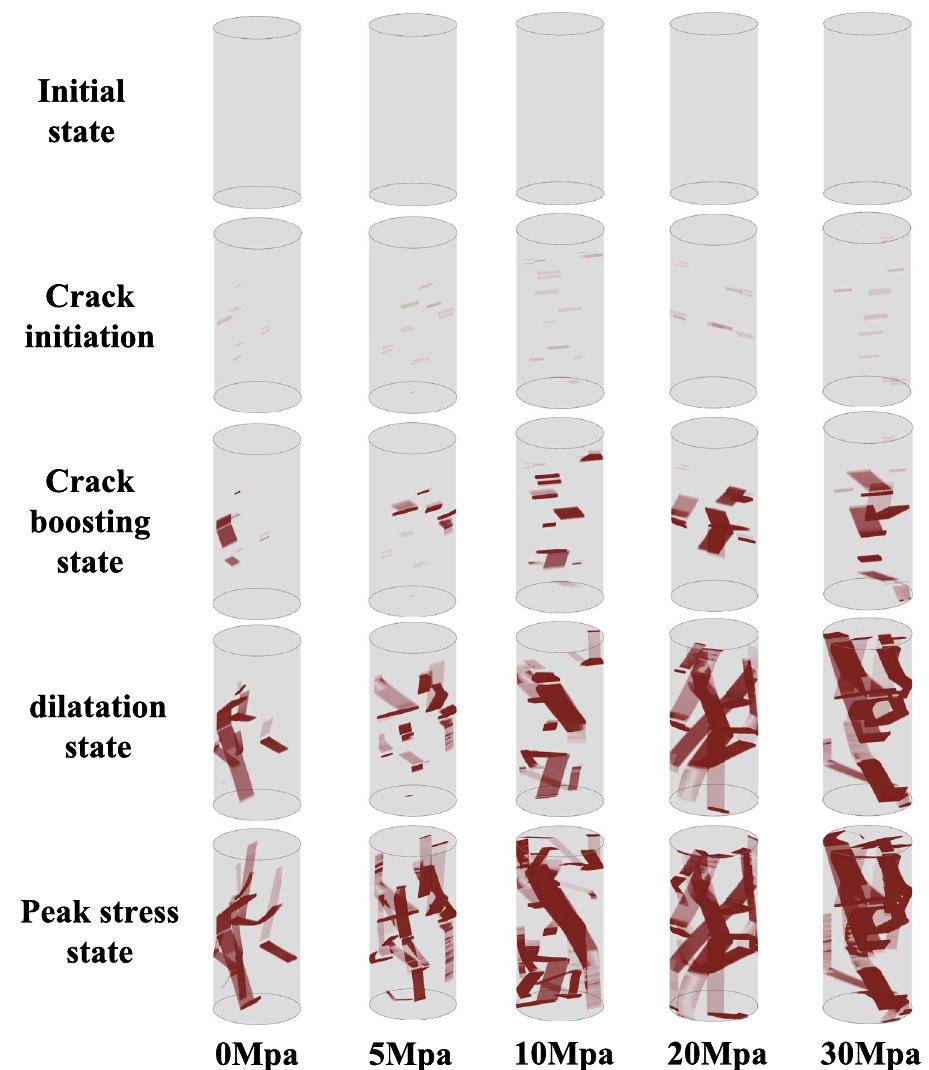
Figure 11. Simulation of the fracture behavior under different confining stress.